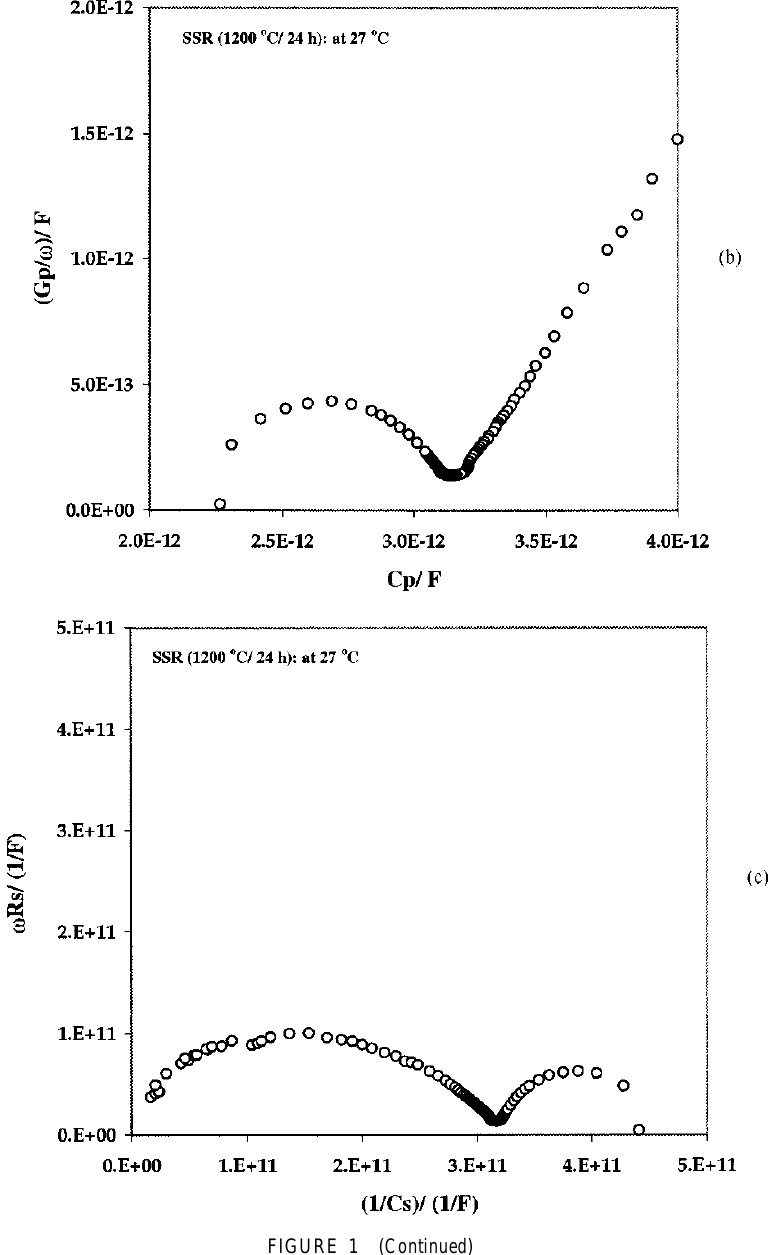
When the LP = CPA technique was applied to the same data in the C *-plane (Fig. 1b), the finite left-intercept (C ) on the real ( x -) axis was found to be 2.2 pF. A finite intercept on the 2 left-side of the semicircular relaxation in a complex plane formalism is known as the left- intercept [10–13, 16]. The semicircular relaxation between the high-frequency terminal and the low-frequency asymptotic segment yielded the capacitance ( C